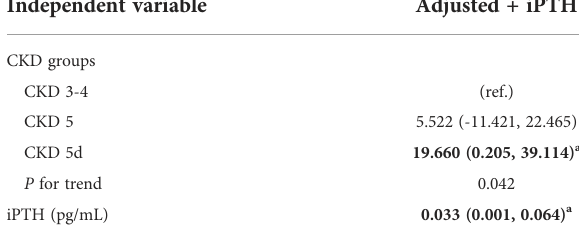
TABLE 3 Association of CKD groups with FF (%) in unadjusted and adjusted models.